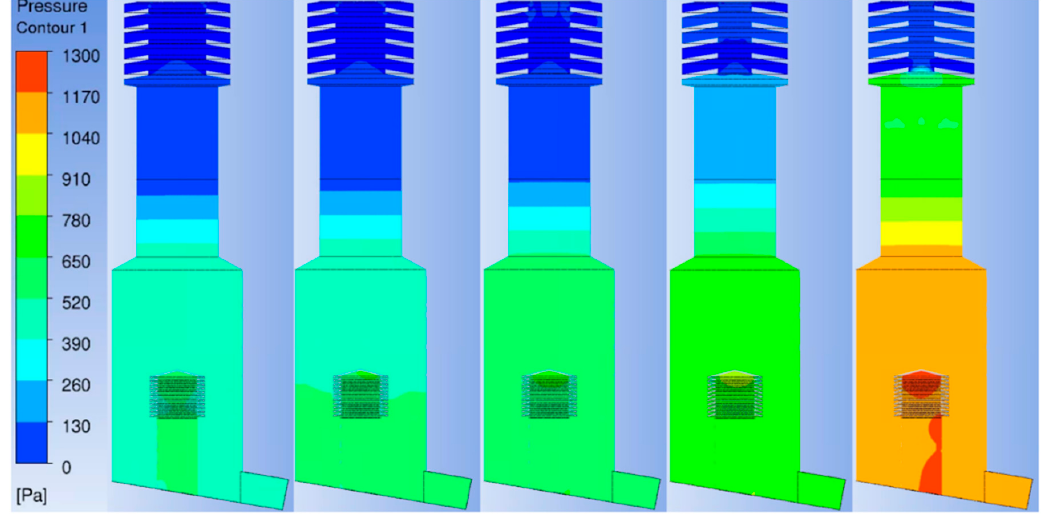
Figure 18. Pressure contour according to the vane length in the outer vane type.